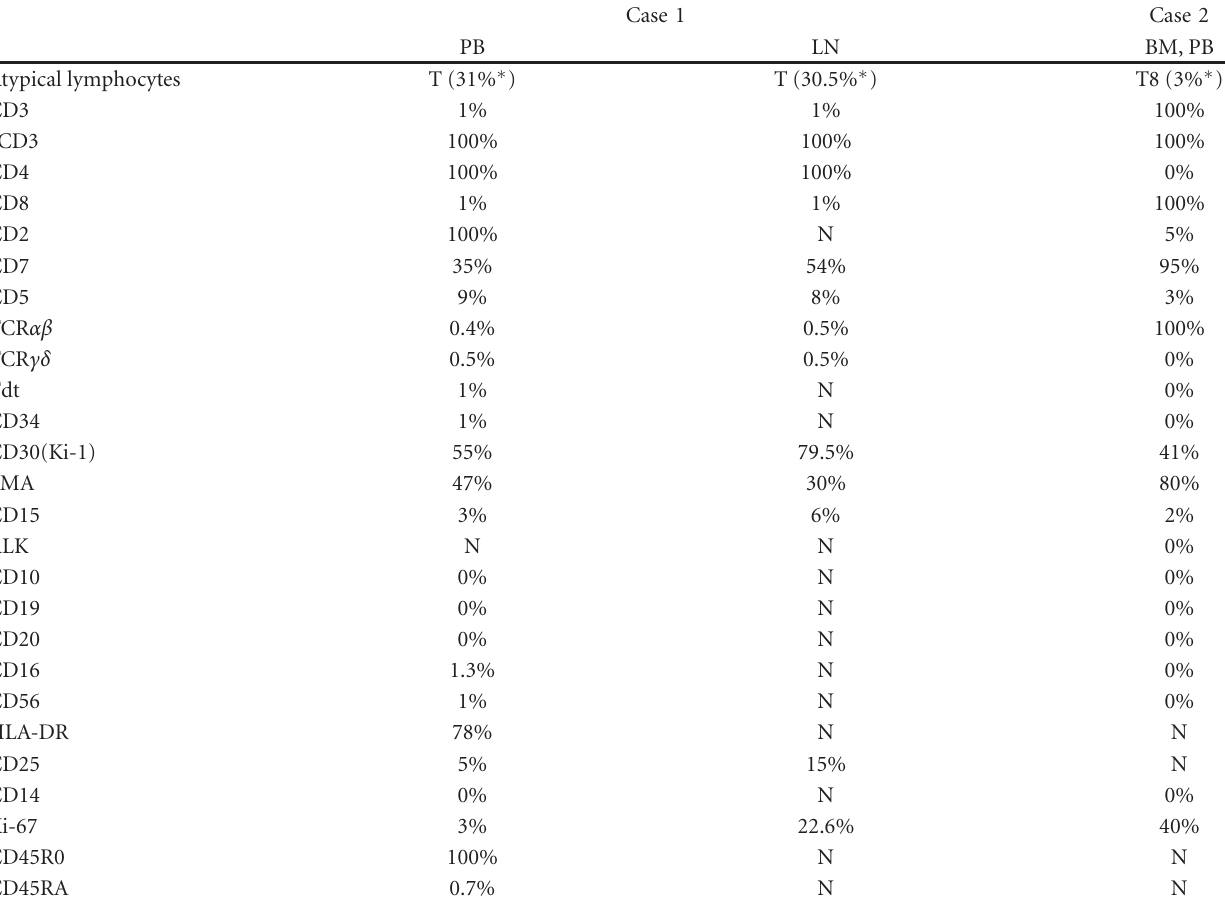
Table 2: Immunophenotype of atypical cell